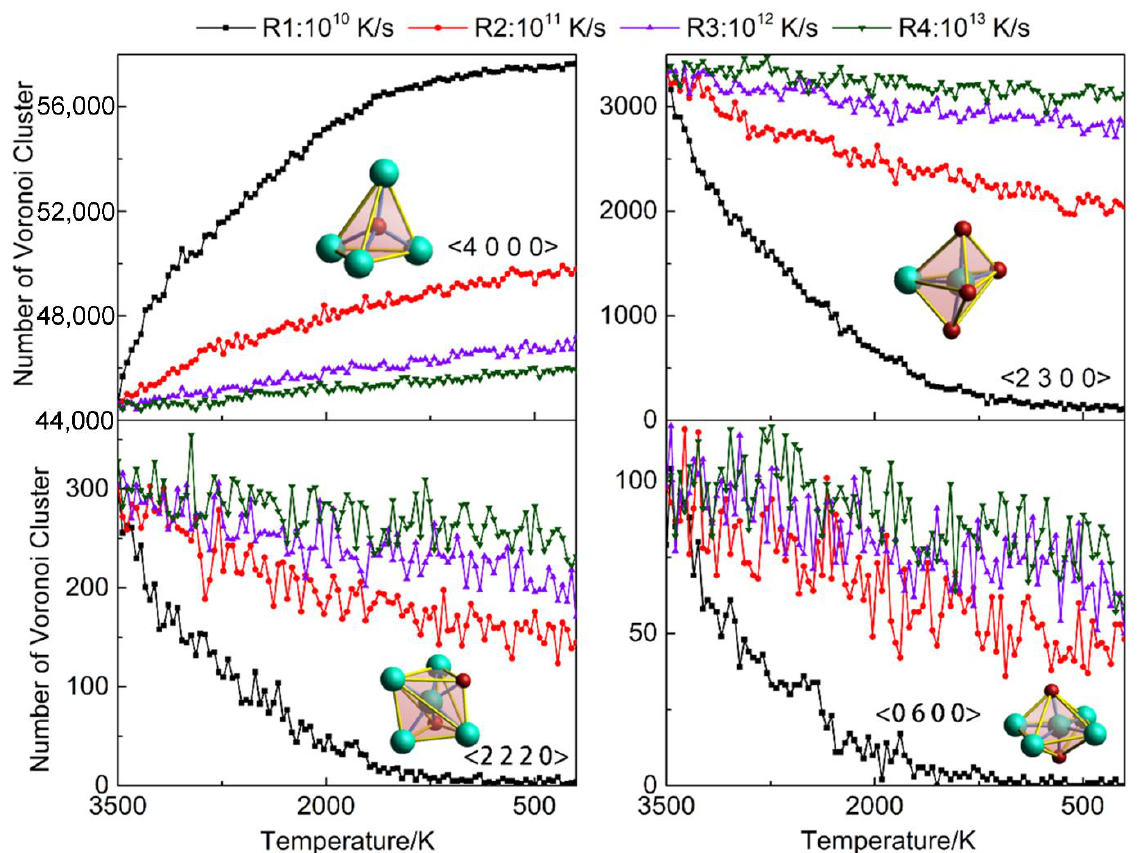
Figure 6. Variation in Voronoi polyhedron clusters as a function of temperature at four cooling rates.